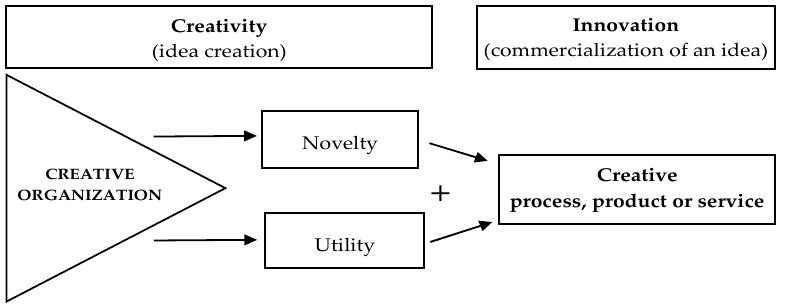
Figure 1. Interrelations between entrepreneurship, creativity, and innovation in a creative organiza- tion. Source: created by the authors.